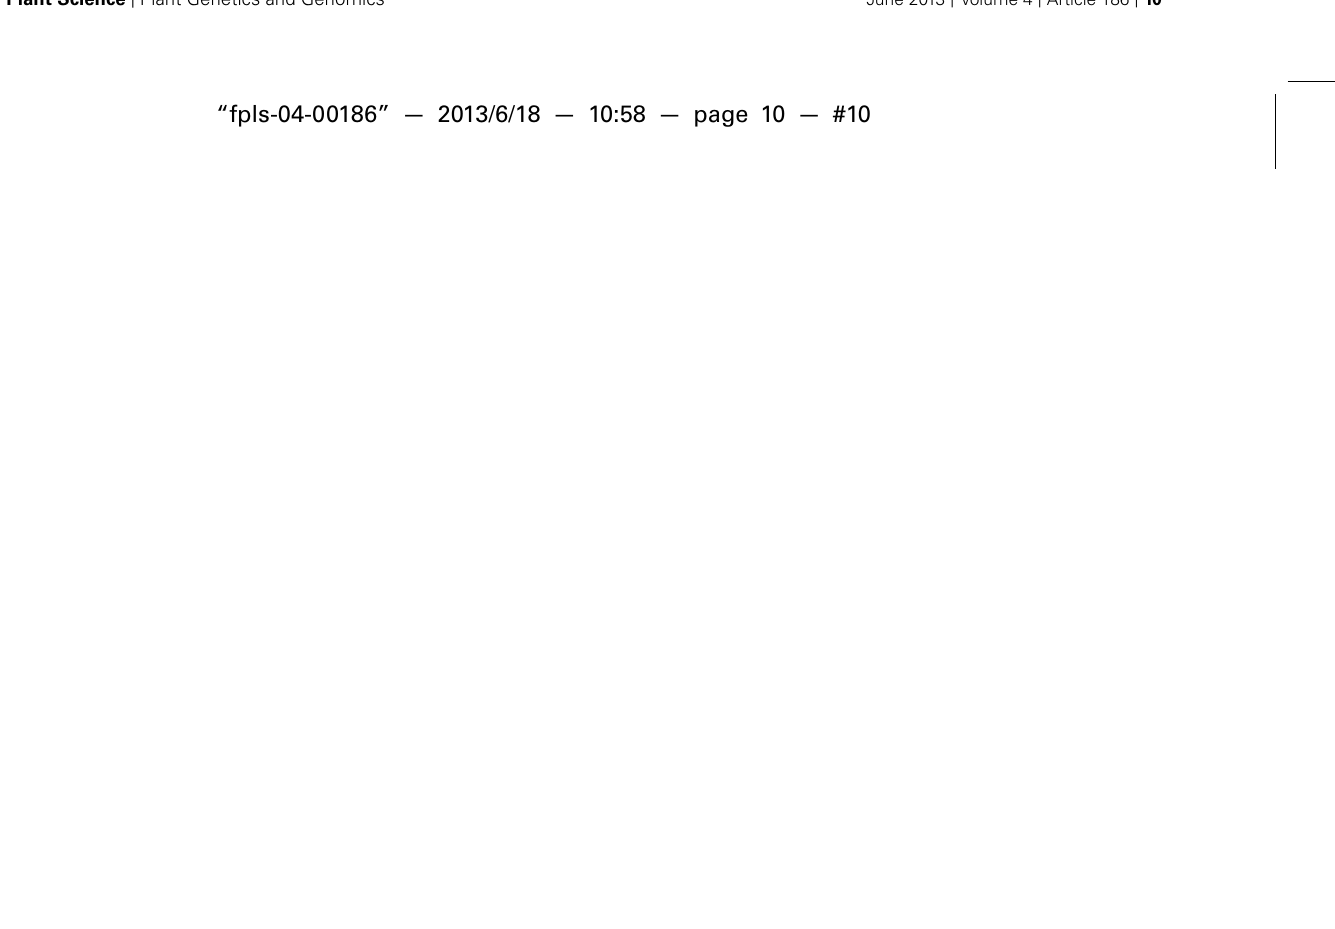
enhancing acropetal (ap) and basipetal (bp) auxin transport. BR promotes LR initiation by increasing acropetal (ap) auxin transport. Low concentrations of ethylene (low concentrations of exogenous ACC) promote LR initiation by increasingTrp-dependent auxin synthesis mediated byWEI2 andWEI7. Normal ABA signaling mediated by ABI3 is necessary for proper auxin responsiveness for LR initiation. Auxin also promotes LR primordium development but CK inhibits LR primordium development and affects auxin maxima by altering the expression of PINs. ABA inhibits LR emergence whereas auxin and ethylene (via high concentrations of exogenous ACC) promotes LR emergence (modified from Fukaki andTasaka,